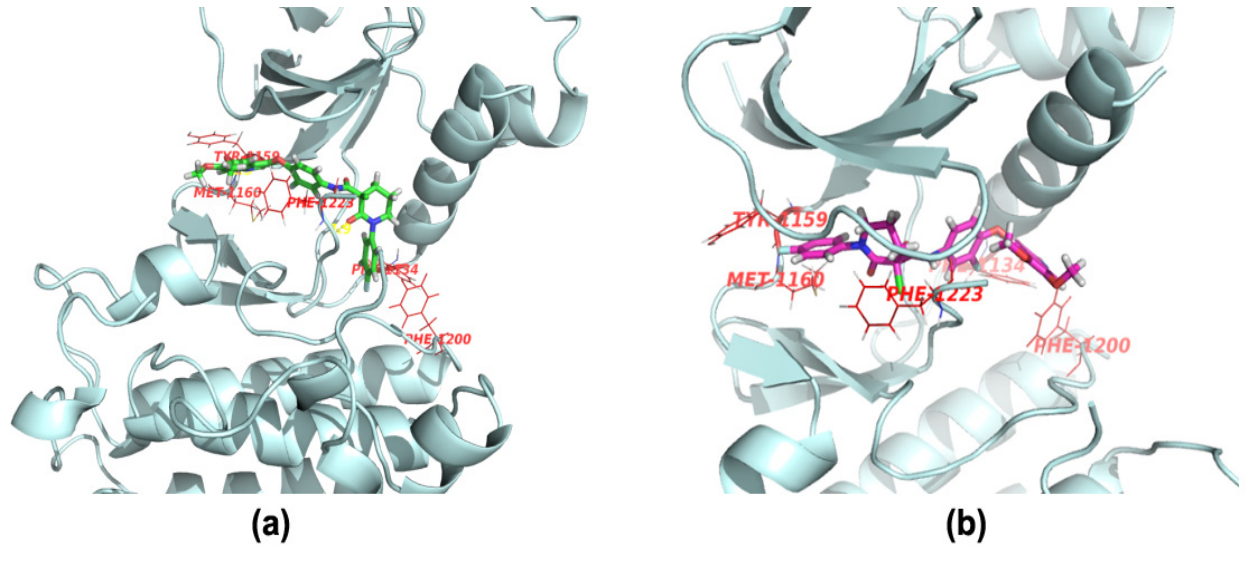
Figure 3. Binding poses of compounds ( R )- 20b and ( S )- 20b with